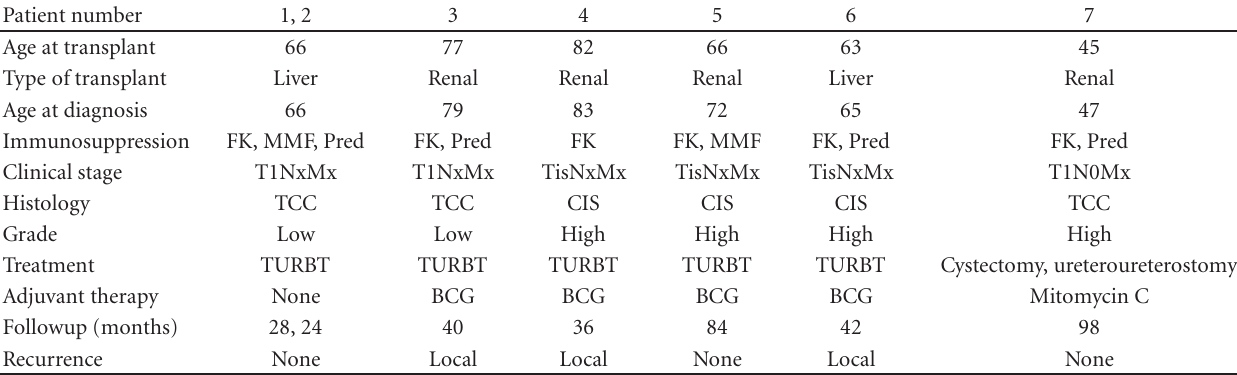
Table 1: Characteristics of patients with nonmuscle-invasive TCC of the bladder.